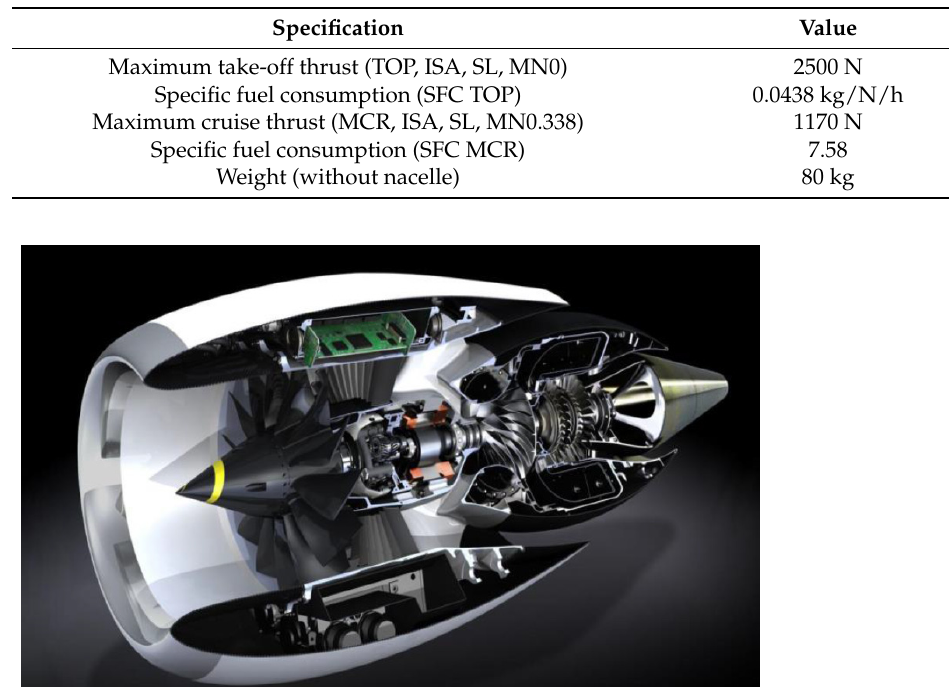
Table 1. Specification of target engine.